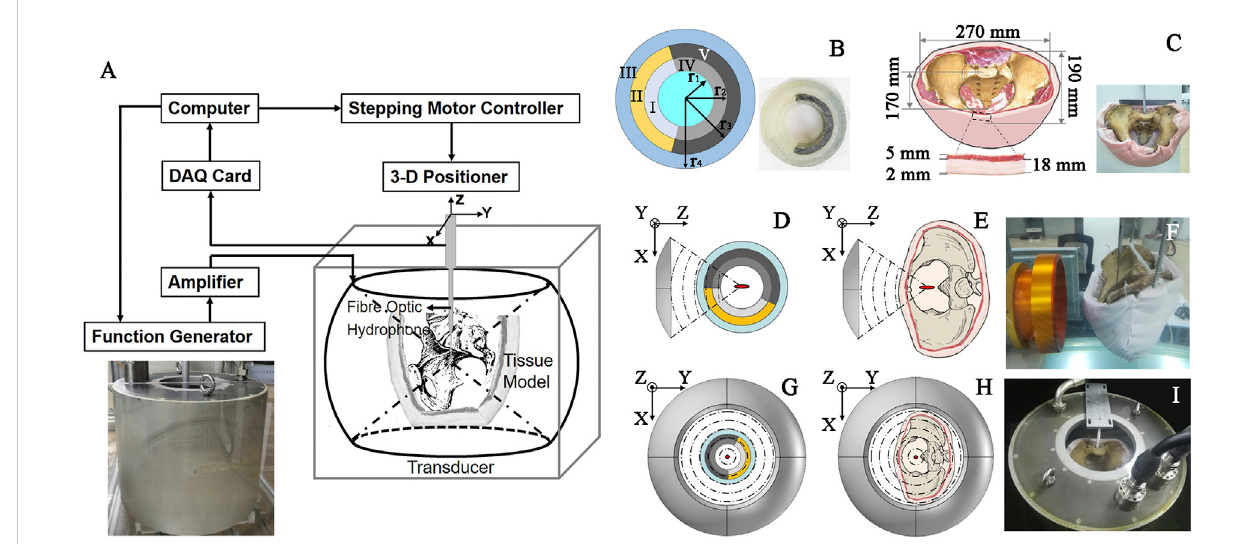
FIGURE 1 Schematic diagram of (A) the acoustic fi eld mapping in different media with an inset of photograph of the spherical cavity transducer, (B) multi- layered concentric-cylinder tissue phantom ( r 1 = 50.57 mm, r 2 = 63.21 mm, r 3 = 75.86 mm, r 4 = 88.50 mm, H = 100 mm, angles of I-II and IV-V are 145 ° and 215 ° , respectively) with an inset of its photo, (C) an adult male pelvis enclosed by porcine skin, fat, and muscle with an inset of its photo, concave transducer through (D) Phantom and (E) Tissue, spherical cavity transducer through (G) Phantom and (H) Tissue, and the photo of acoustic fi eld mapping using (F) the concave and (I) spherical cavity transducers in Tissue.